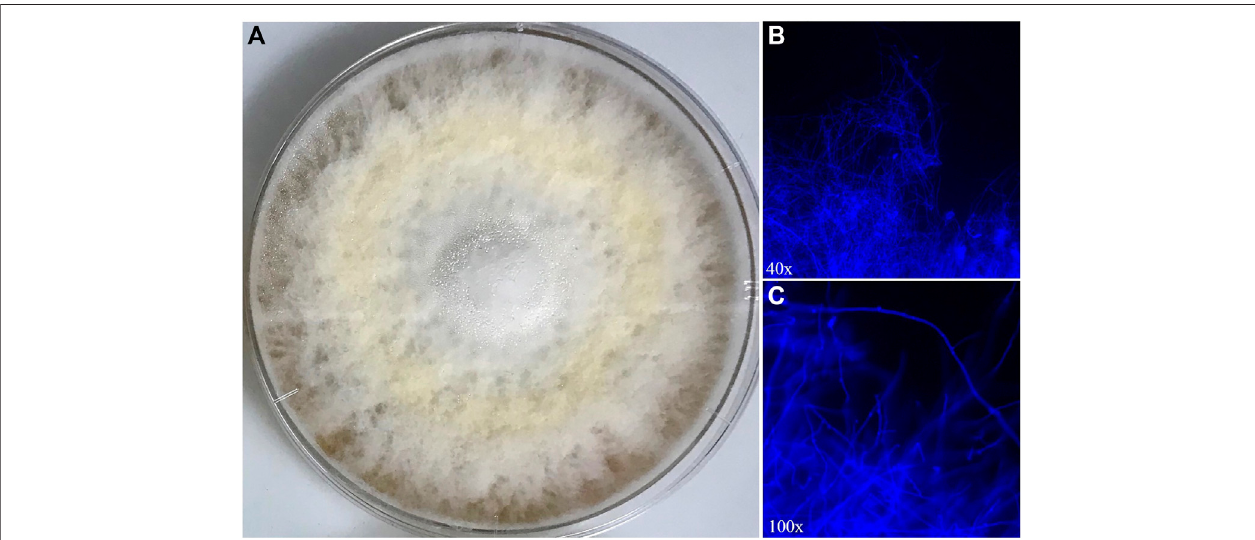
FIGURE 1 | Pleurotus ostreatu s, commonly known as the oyster mushroom. P. ostreatus mycelial growth on a malt extract agar plate after 7 days incubation at 22 ° C (A) . The plate was inoculated in the centre and the fungushas grown to the edges and fi lled the entire plate. Microscopic images ofmycelium from the plate on the left after staining cell walls with calco fl uor white ( fl uorescent brightener 28). Images taken under fl uorescent microscopy at 40 × (B) and 100 × (C) magni fi cation. Image supplied by Alex